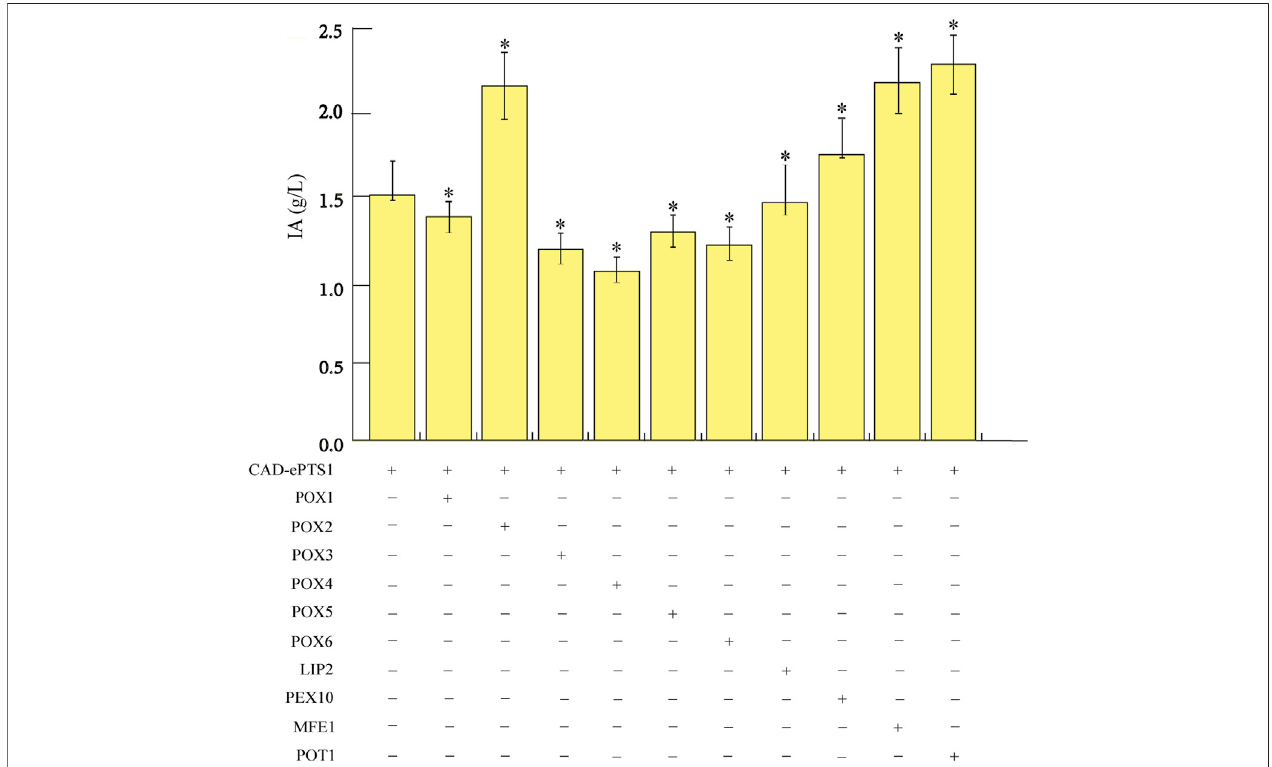
FIGURE 5 | Effects of overexpressing genes involved in the acetyl-CoA production pathway on IA production. The genes involved in the acetyl-CoA production pathway, consisting of LIP2, POX1-6, MFE1, POT1 and PEX10, were overexpressed individually. Titers of IA produced by the strains were quanti fi ed after 6 days of cultivation in shake fl asks with YPO medium. All values presented are the mean of three biological replicates ± standard deviation. * p < 0.05, signi fi cantly different from control by